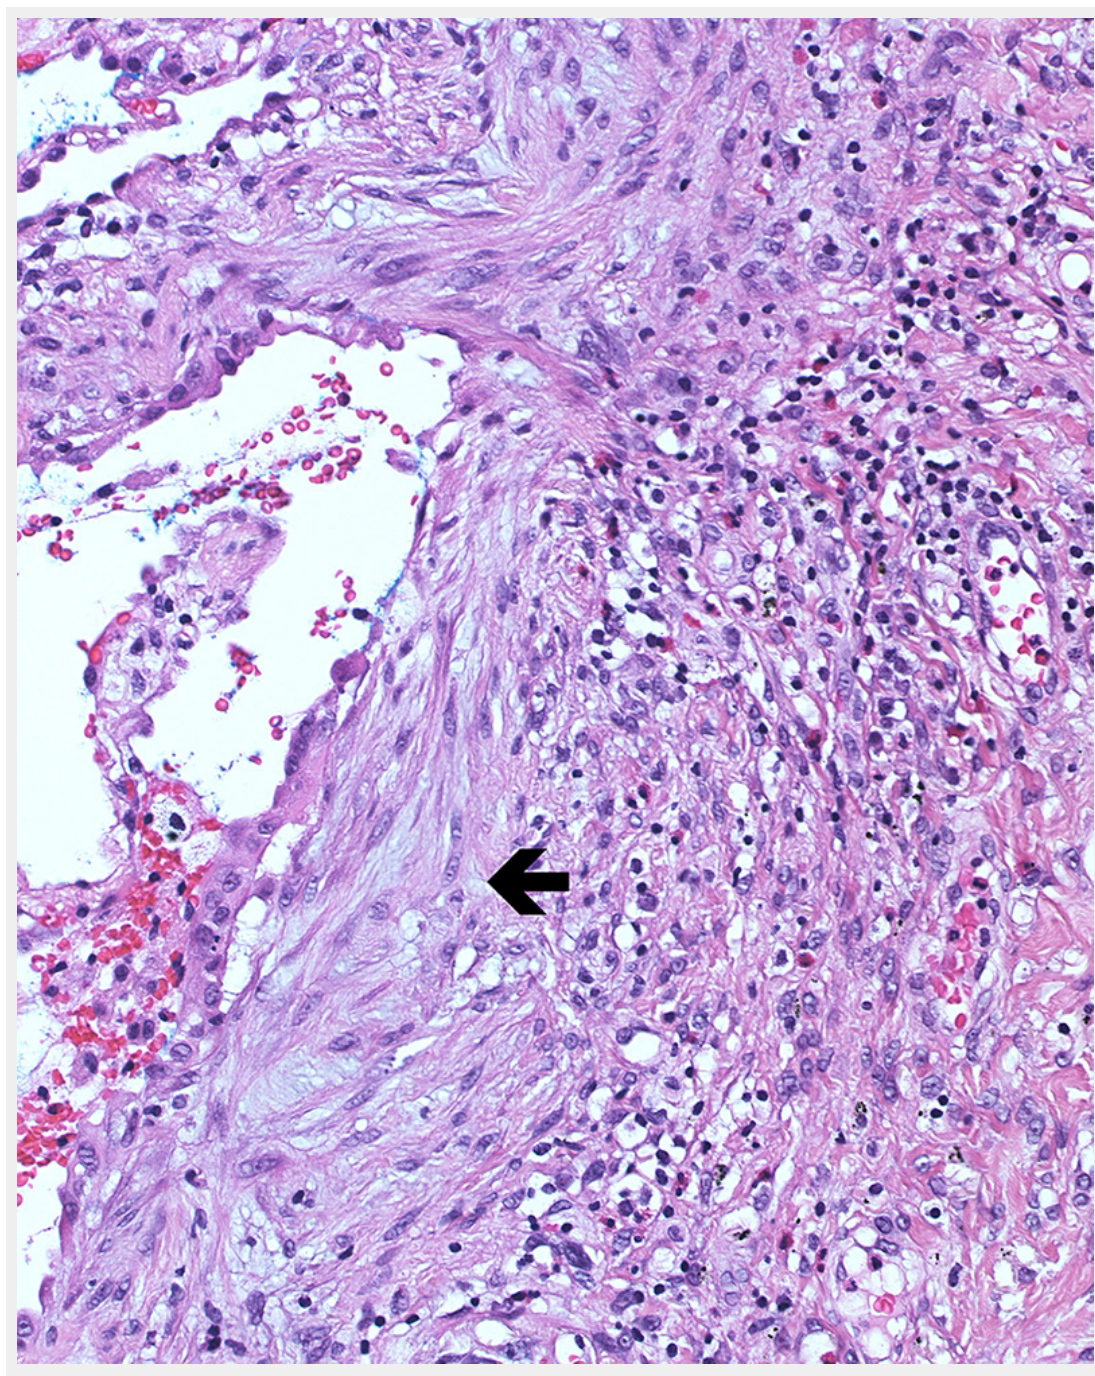
Figure 2 Histological usual interstitial pneumonia pattern: A typical fibroblast focus is shown (arrow). (Haematoxylin and eosin staining; magnification